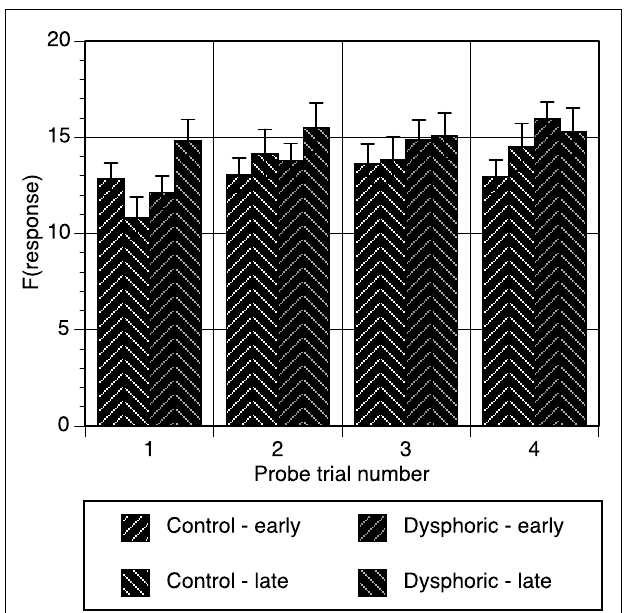
FIGURE 1 | Response frequency on the early and late buttons during each probe trial averaged over time segment for the control and dysphoric groups. Error bars correspond to the standard error of the